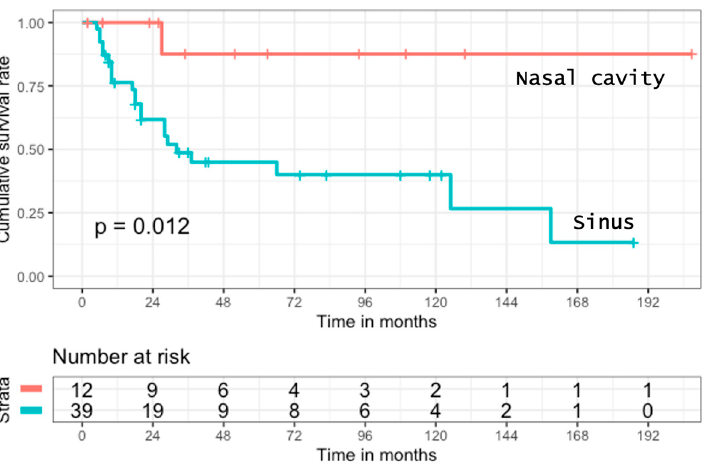
Figure 1. Overall survival in patients with SNSCC, curatively treated, according to primary local- ization.